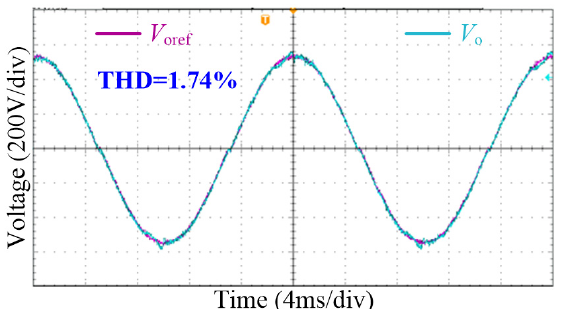
Figure 11. Robustness experimental results.